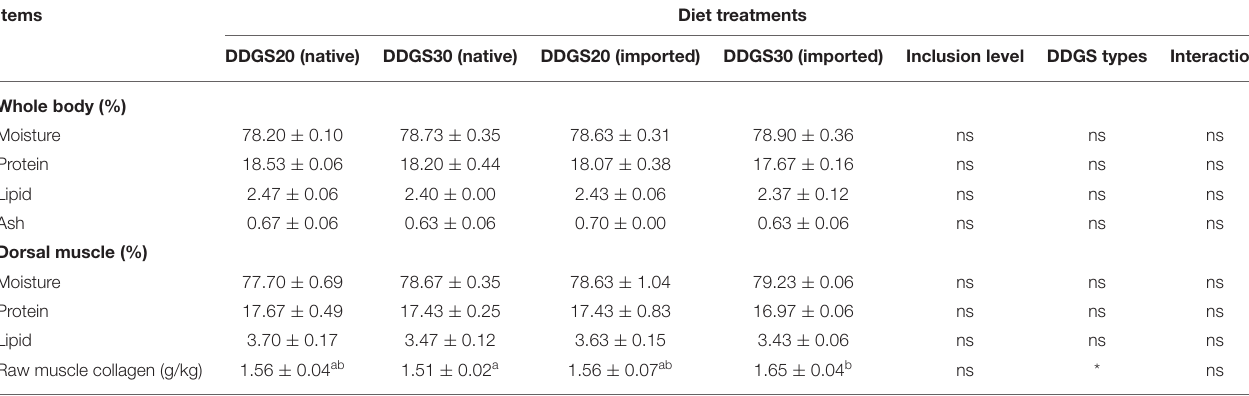
TABLE 7 | The effects of different types and levels of dietary DDGS on body and dorsal muscle proximate composition a . Items